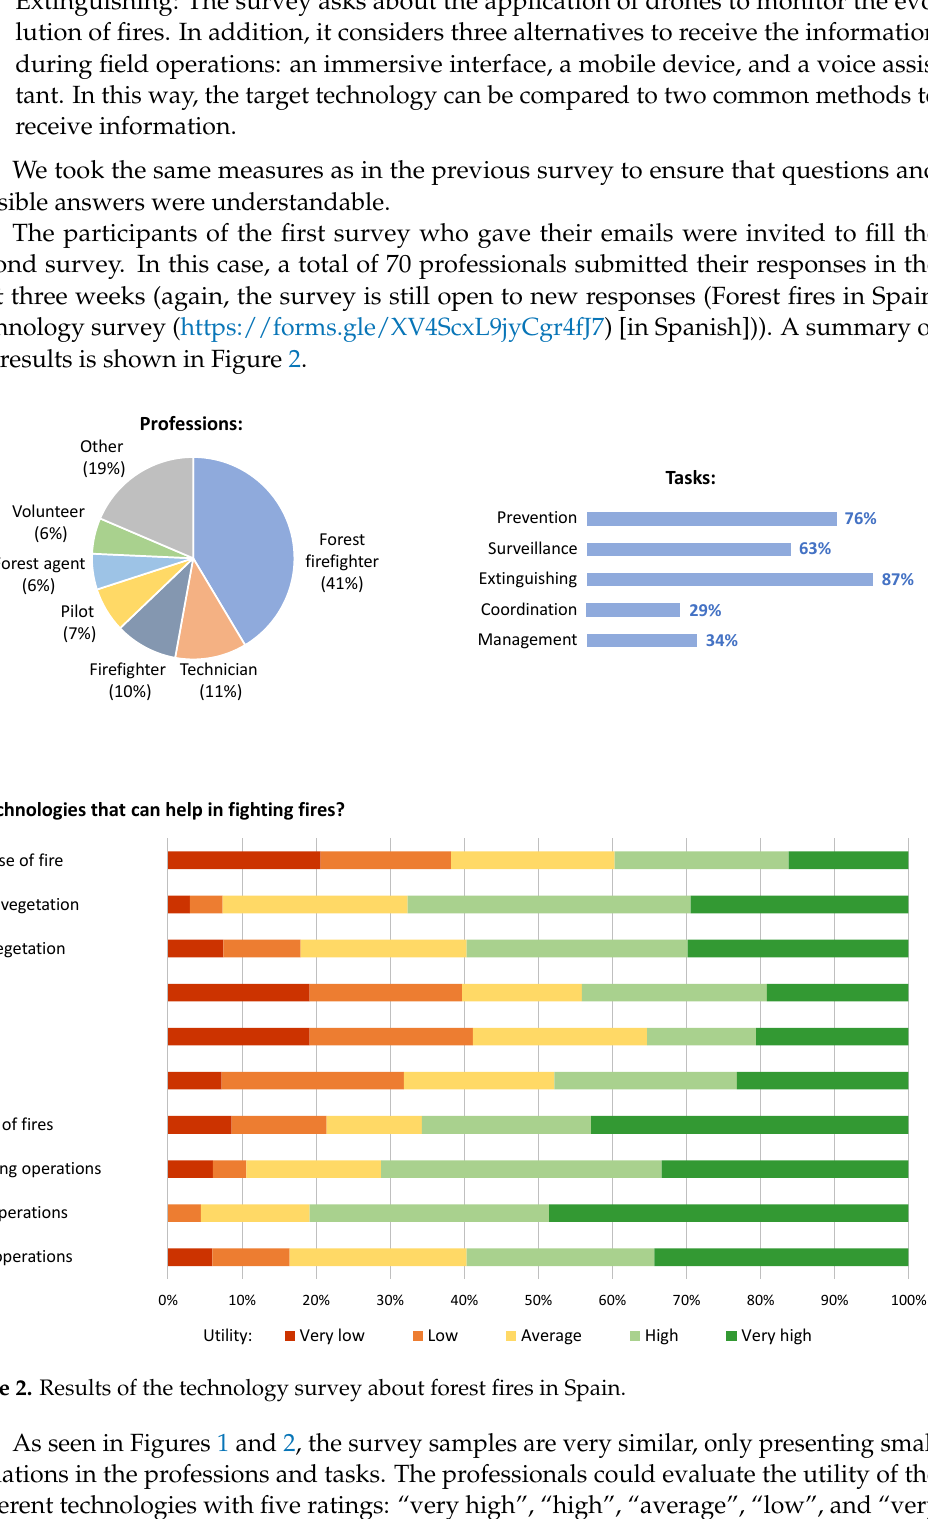
(including “low” and “very low”